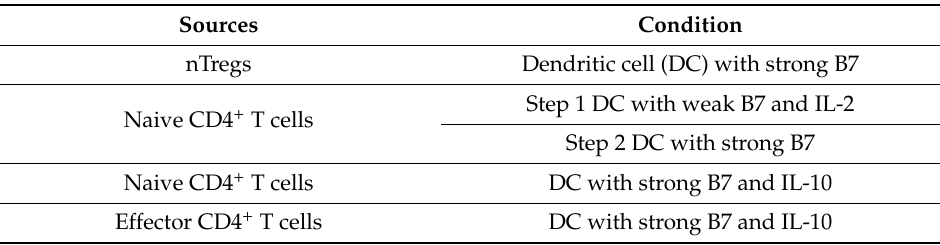
Table 4. IL-10 producing (activated) Treg sources